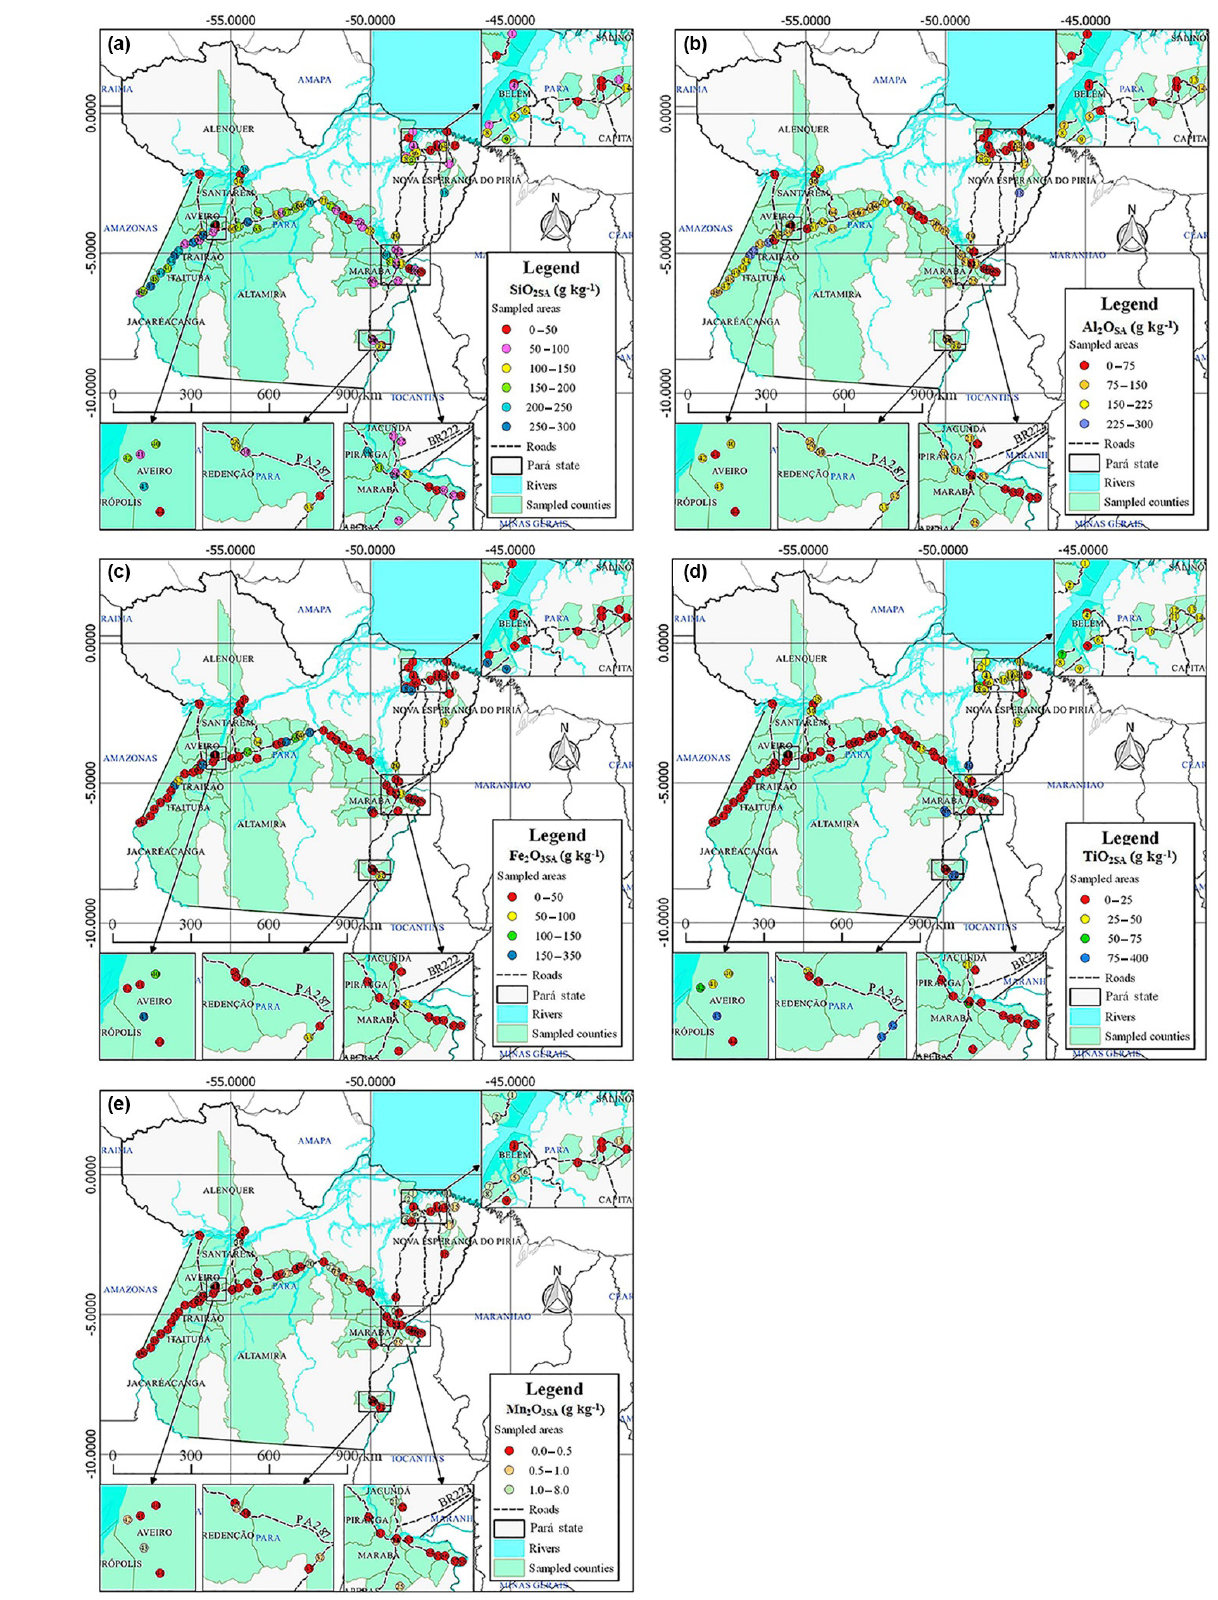
Figure 6. Spatial distribution map of Si (a) , Al (b) , Fe (c) , Ti (d) , and Mn (e) oxides of the soils of the state of Pará. SOIL, 4, 195–212,